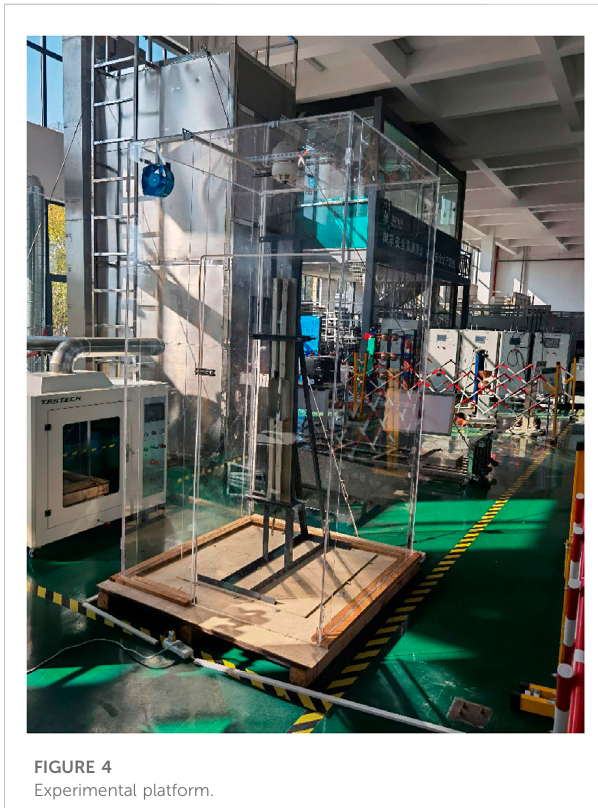
FIGURE 4 Experimental